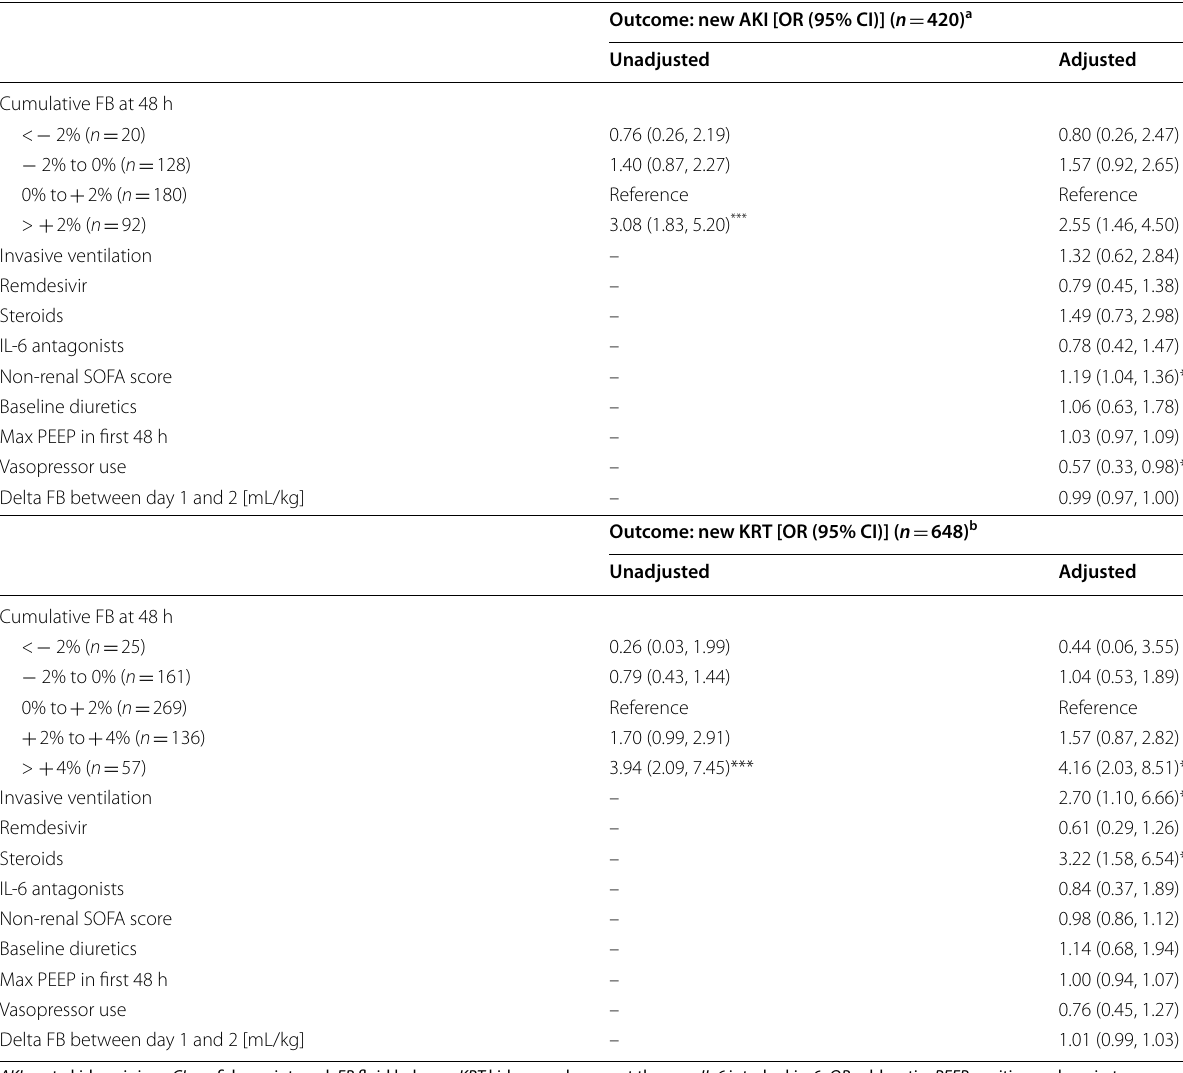
Table 4 Association between cumulative fluid balance during the first 48 h after hospital admission and the development of new AKI and